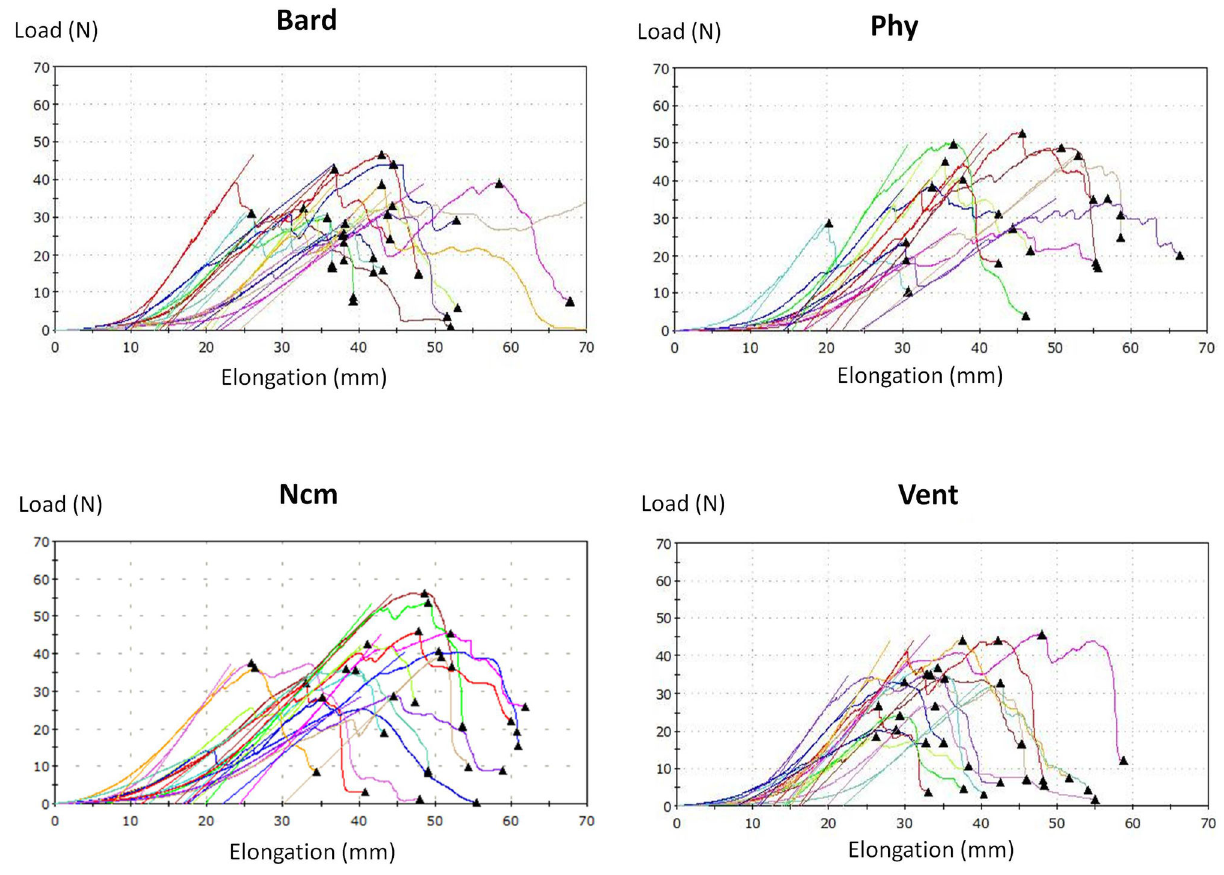
Figure 8. Load (N)/Elongation (mm) curves of the different meshes. The Load/Elongation curves of all the different groups, at 90 days, were represented in the figure. From these curves the Young´s modulus of the different groups of our study were calculated and statistically analyzed. Bard mesh TM (Bard), Physiomesh TM (Phy), new composite mesh (NCM), Ventralight TM (VL).